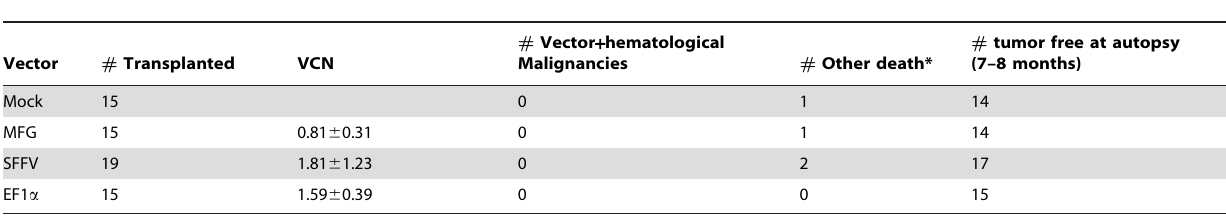
Table 3. Malignancy incidence in primary recipient mice in Exp 2 (Donor: CD45.1 + ; Recipient: CD45.2 + ).